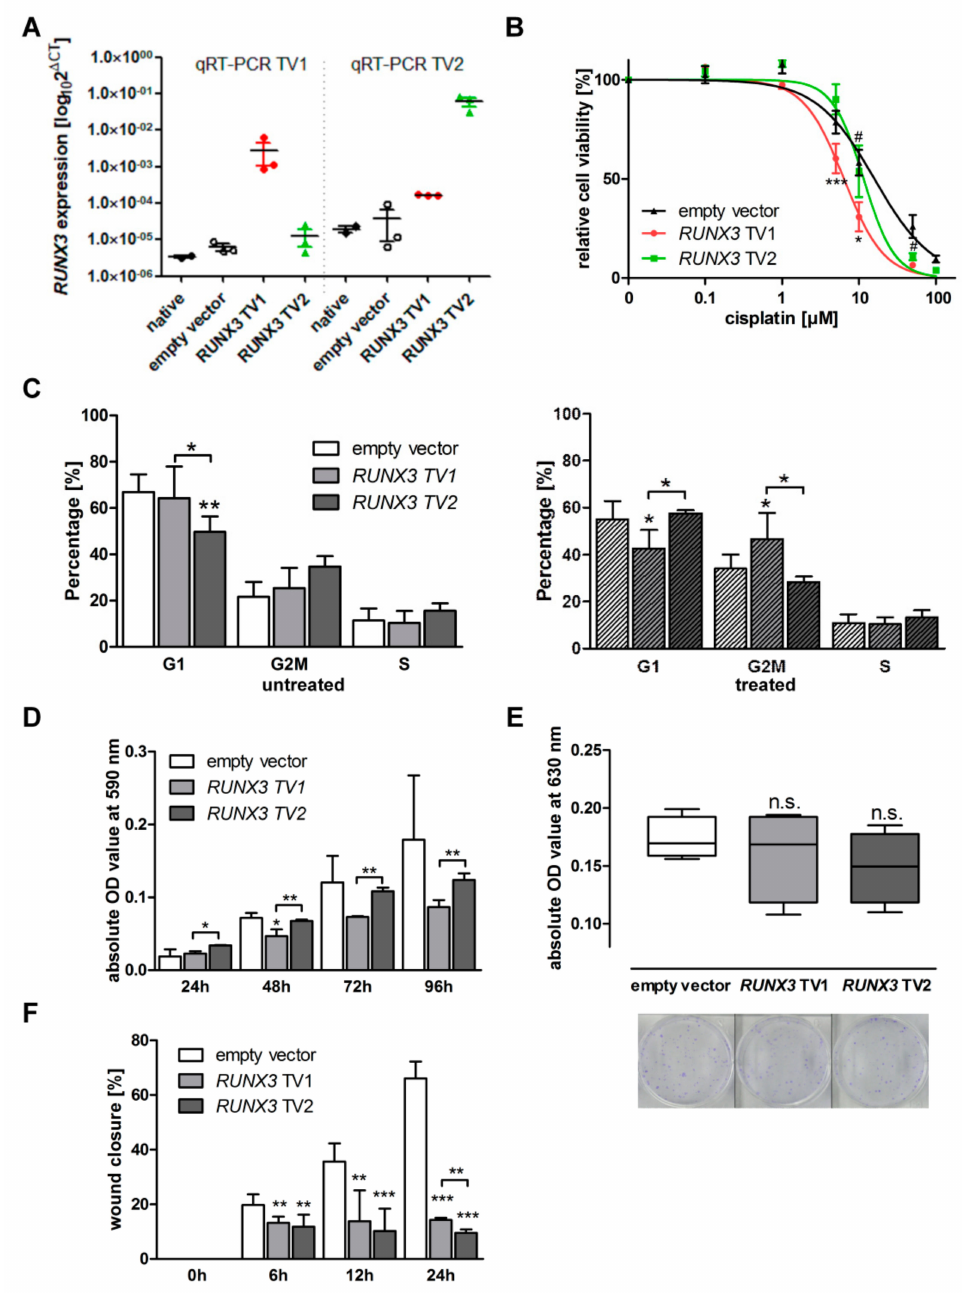
Figure 1. Functional characteristics of RUNX3 overexpression model of A13-2-12 cells. ( A ) Quantification of RUNX3 transgene overexpression in A13-2-12 cells compared to the endogenous expression in native and empty vector control cells, n = 3. ( B ) IC50 determination against cisplatin. The difference between the variants was significant (using 2-way ANOVA, indicated by #), IC50 values: empty vector 15.9 µ M (12.3–20.5 µ M), RUNX3 TV1 6.38 µ M (5.48–7.42 µ M), RUNX3 TV2 11.5 µ M (9.05–14.6 µ M) n = 5. ( C ) A13-2-12 cells expressing RUNX3 TV1 responded with an increase in the proportion of cells in G2-M phase after treatment. n = 4. ( D ) The overexpression of TV1 resulted in a reduced proliferation compared to cells expressing TV2. ( E ) RUNX3 overexpression did not affect the ability to form colonies. Respective crystal violet staining of the colonies is shown below the absolute quantification of the measured optical density (OD) values n = 4. ( F ) The migration capacity was significantly reduced by RUNX3 TV1 and TV2 overexpression compared to empty vector. The strongest effect was present in TV2 expressing A13-2-12 cells compared to the control cells, n ≥ 3. ( F ) * p < 0.05, ** p < 0.01, *** p < 0.001 in 2-way